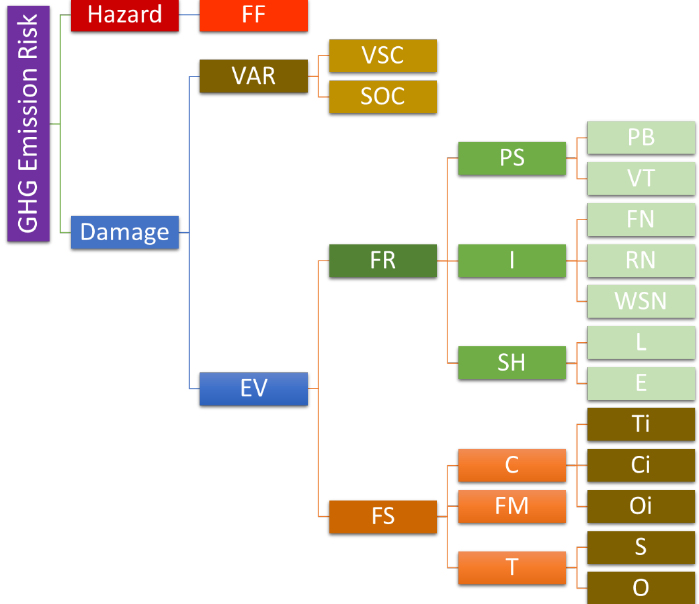
Figure 1. General scheme of the emission risk model.